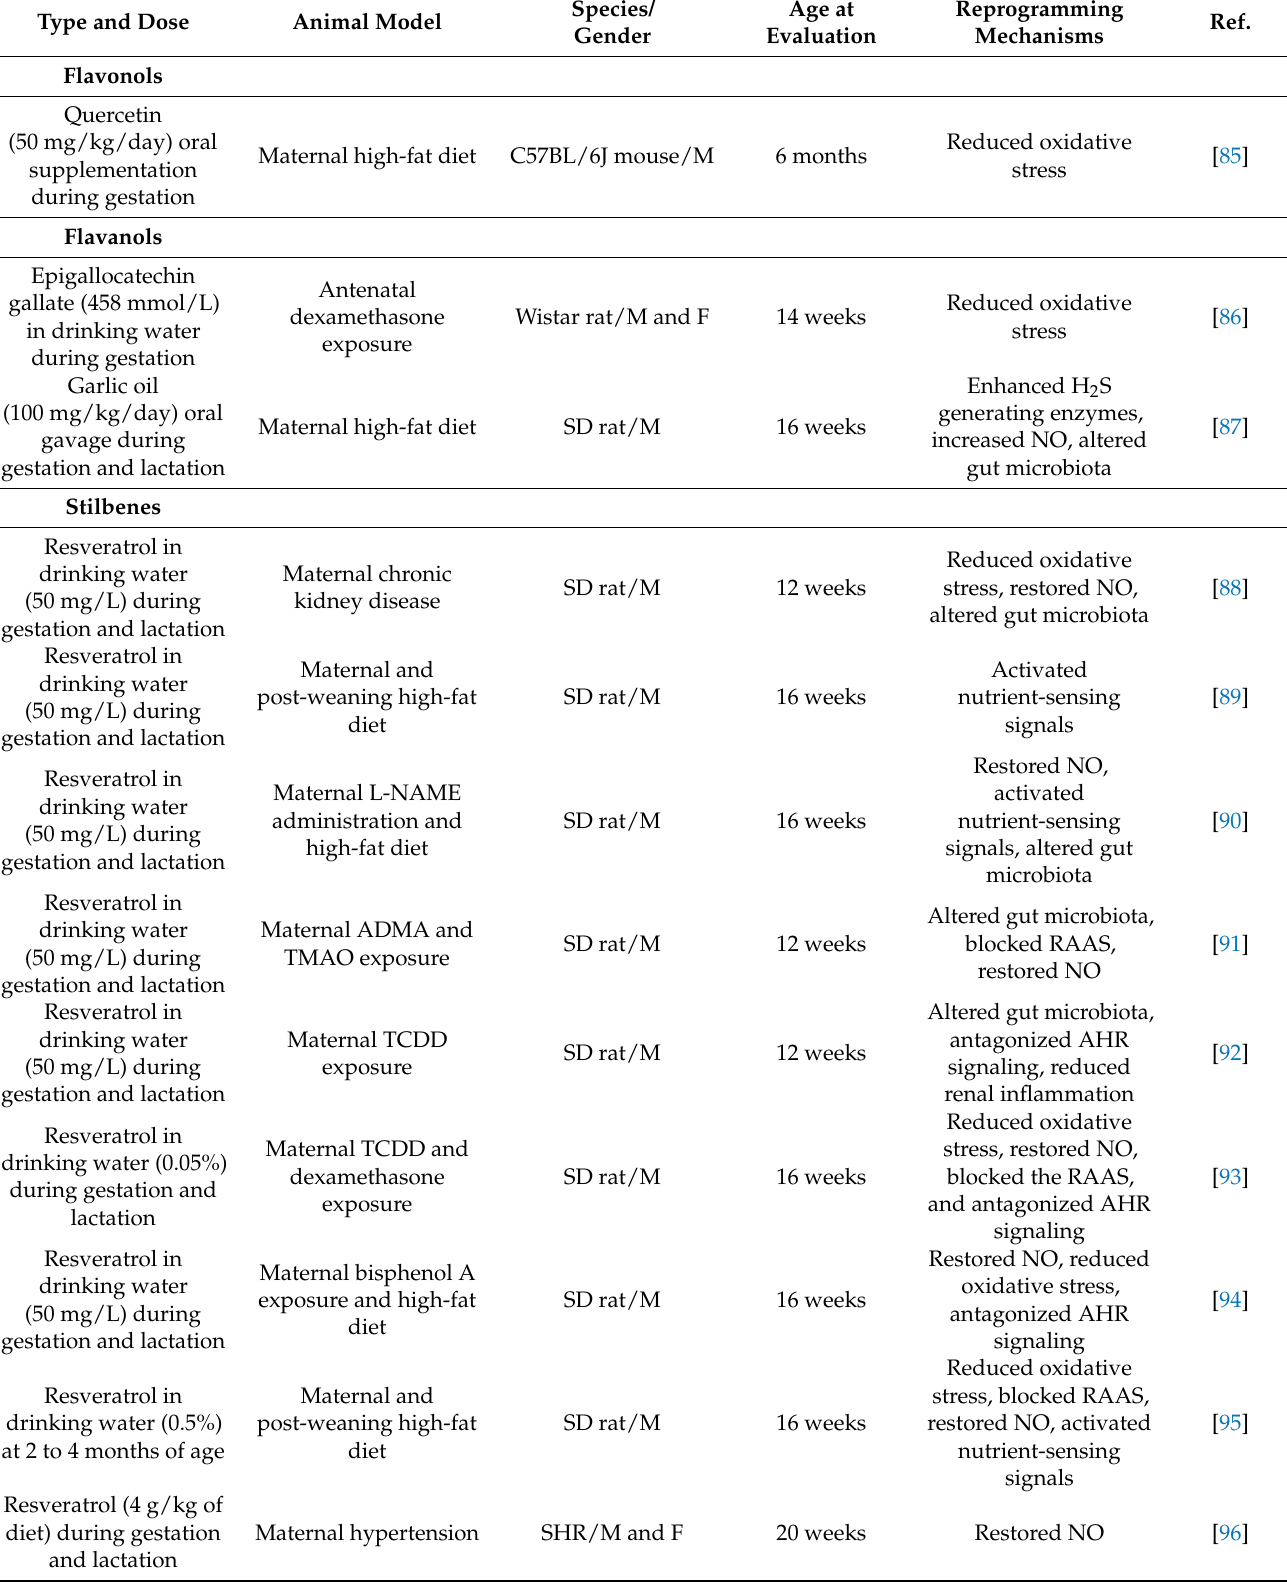
Table 1. Animal studies on polyphenols preventing hypertension in